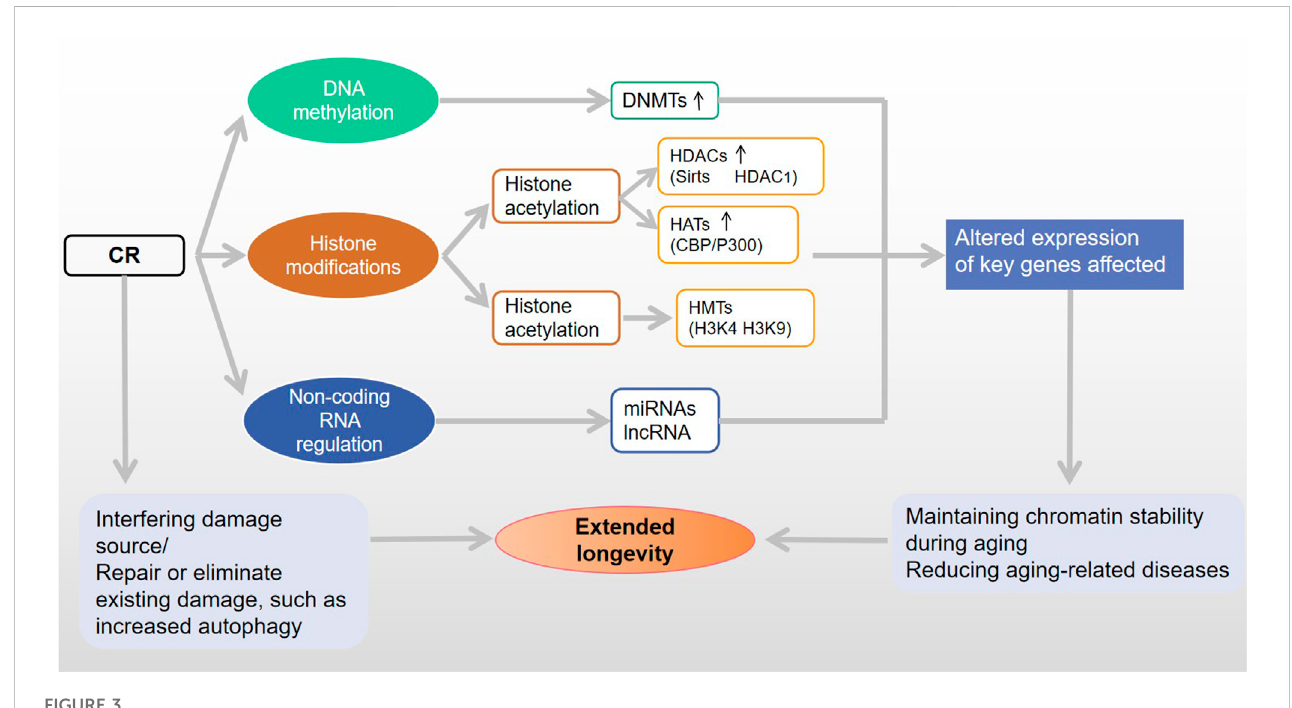
FIGURE 3 CR pathways to extend lifespan through epigenetic modi fi